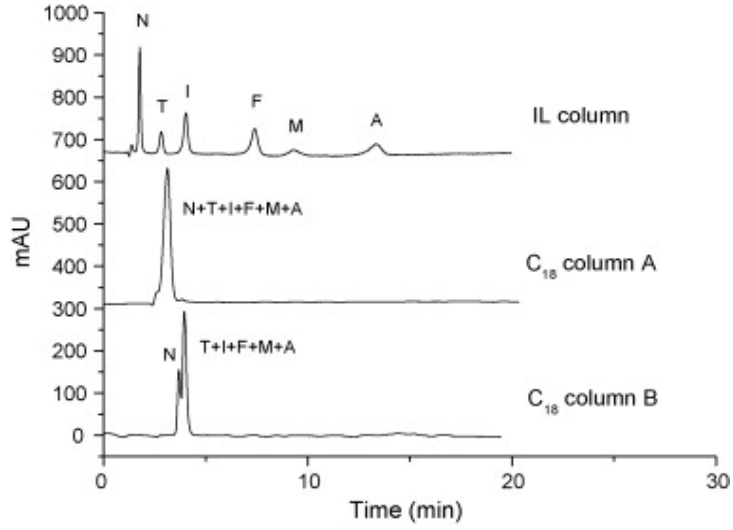
Figure 9. Separation of acidic, basic, and neutral compounds via SFC using the IL-modified column and a commercial C 18 column. Figure adopted with copyright permission from [208].